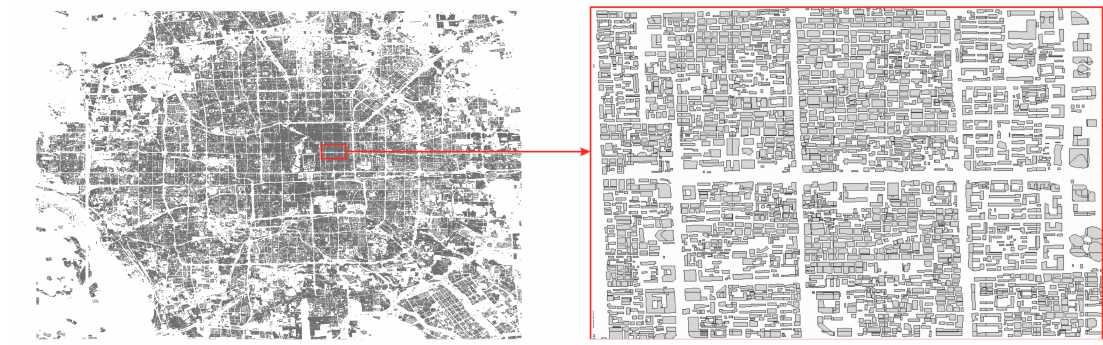
Figure 4. Outline map of buildings in